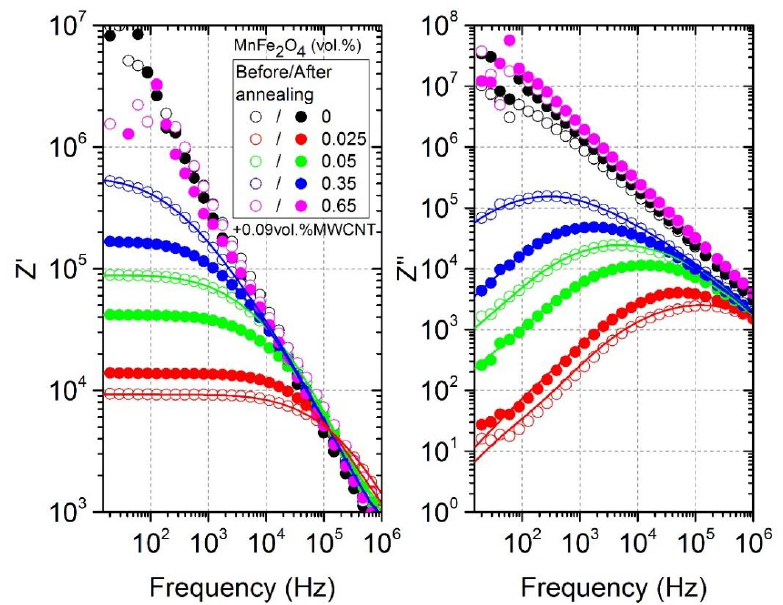
Figure 7. Frequency dependence of the complex impedance before and after annealing at 500 K.